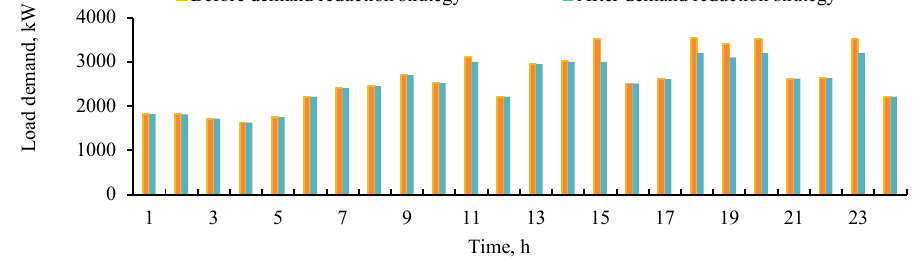
Fig. 5. Load demand after and before